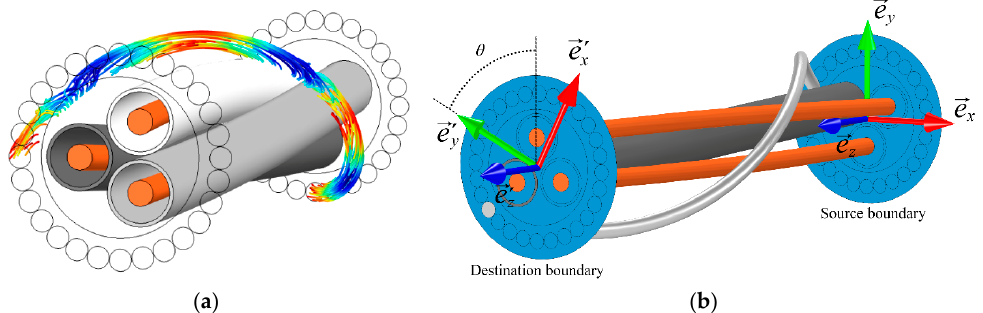
Figure 10. ( a ) Short periodic model for Cable 1; ( b ) Orientation of boundaries in short periodic model for Cable 1.